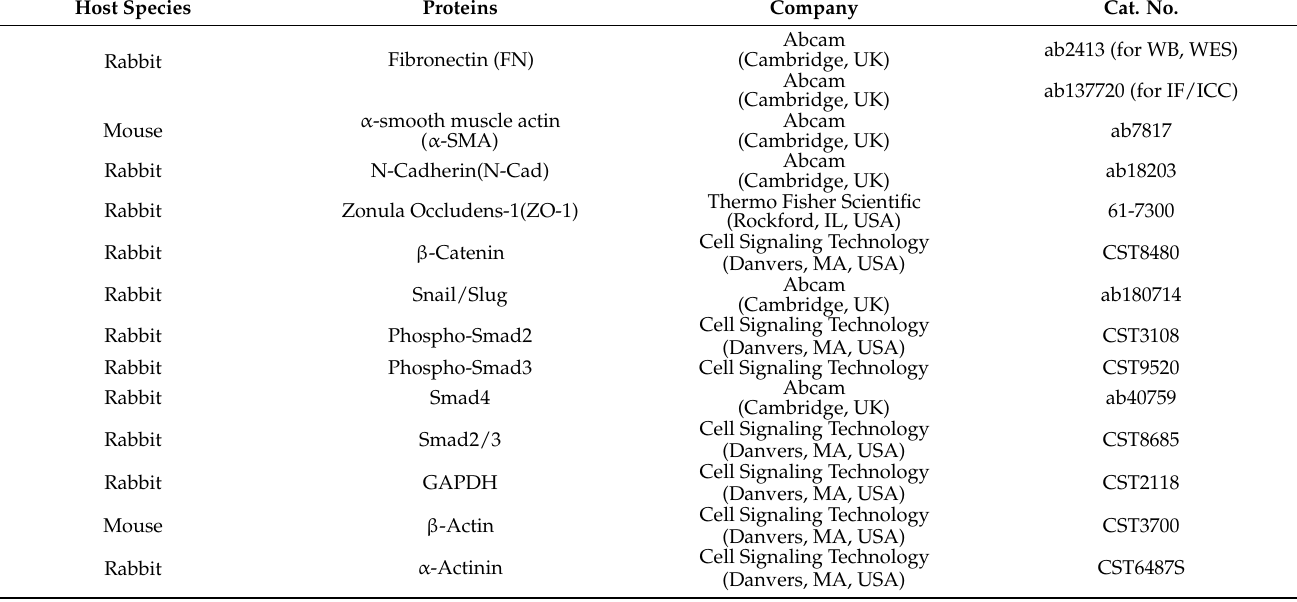
Table 2. Primary antibodies used in this